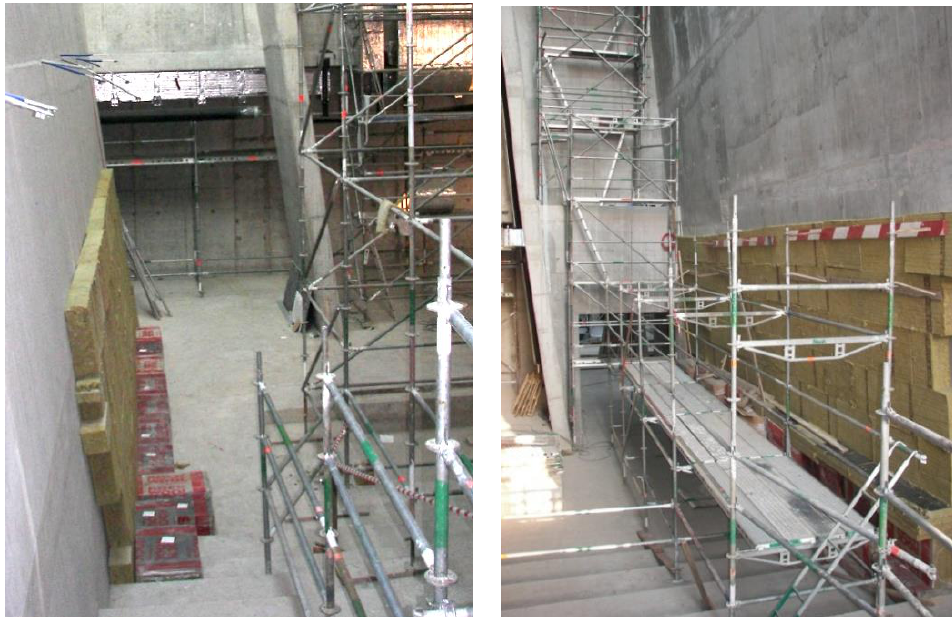
Figure 10. The multi-purpose hall during the acoustic experiment regarding the susceptibility of the room to the formation of the flutter echo. View from the audience on the stage, the left- and right-side walls are shown (photo by A. Kulowski).